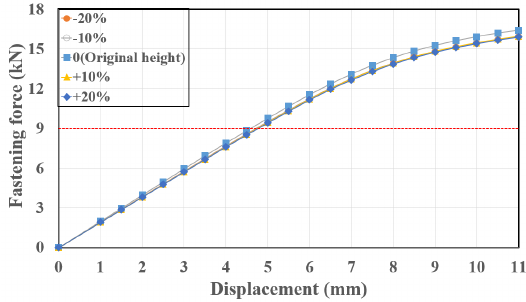
Figure 9. Fastening force vs. displacement diagram varying the spring arm height.